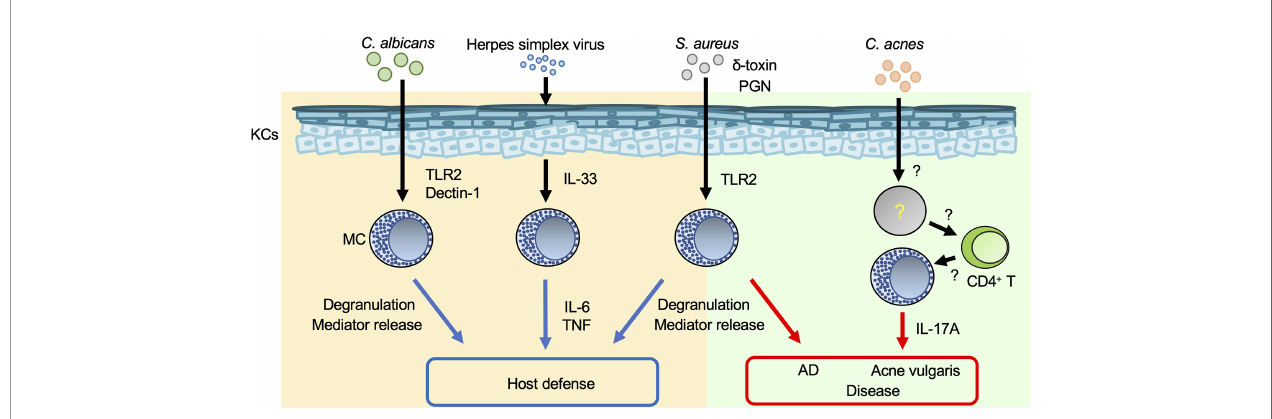
FIGURE 1 | Mast cells in skin in fl ammation during infection. Mast cells (MCs) are important for host defense against various pathogens. On the other hand, inappropriate MC activation during infection results in aggravation of such skin diseases as AD and acne vulgaris. Blue arrows: appropriate MC activation; red arrows: excessive